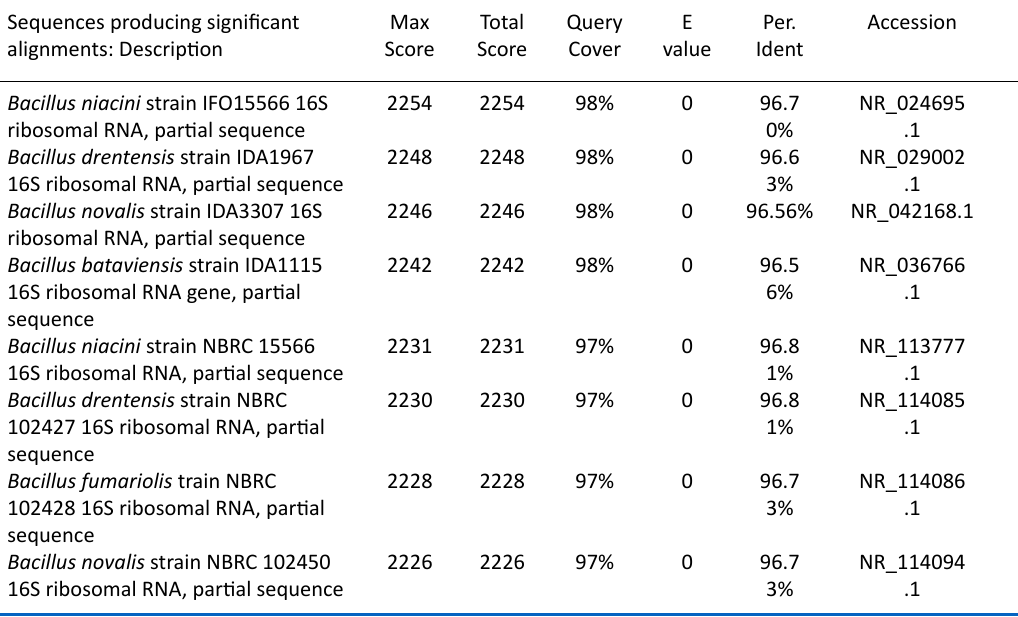
Table 1. Results obtained after the BLAST analysis of sample POSS_8_2 Sequences producing